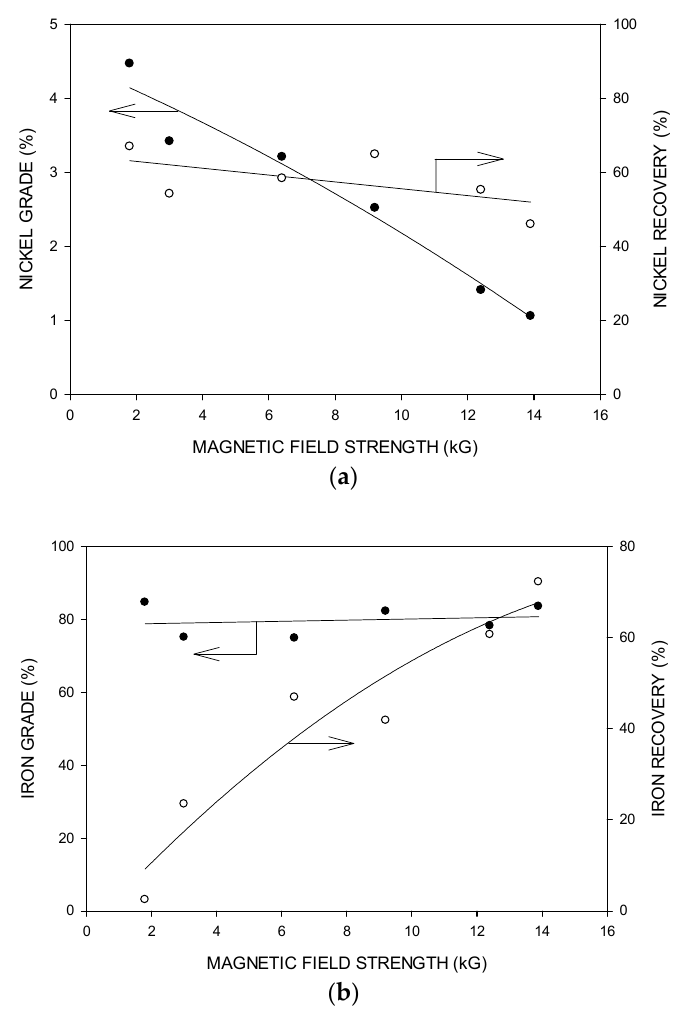
Figure 11. ( a ) Effect of magnetic field strength on nickel grade and recovery; ( b ) Effect of magnetic field strength on iron grade and recovery.